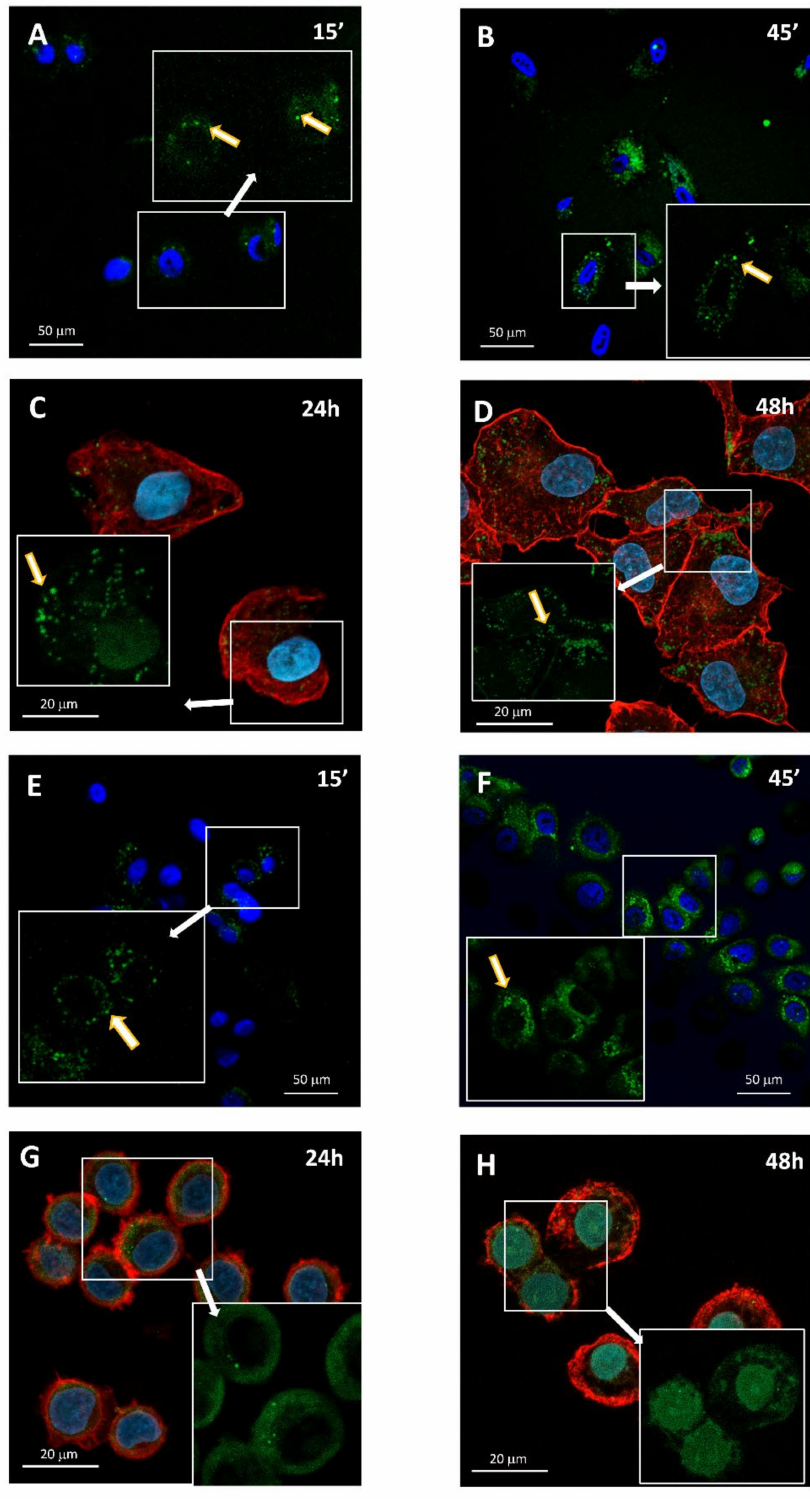
Figure 3. Confocal images of A549 ( A – D ) and SKBR3 ( E – H ) cell lines treated with 10 µ M of peptide conjugate AE-CPP-LTV ( 6 ). Images at 15 min and 45 min were taken in real-time cell culture conditions, and nuclei were stained with Hoechst 33342; images at 24 h and 48 h were taken with fixed cells, and nuclei were stained with Hoechst 33,528 and cytoskeleton with phalloidin. Inserts are representative zones evidencing green fluorescence. Yellow arrows indicate green fluorescent